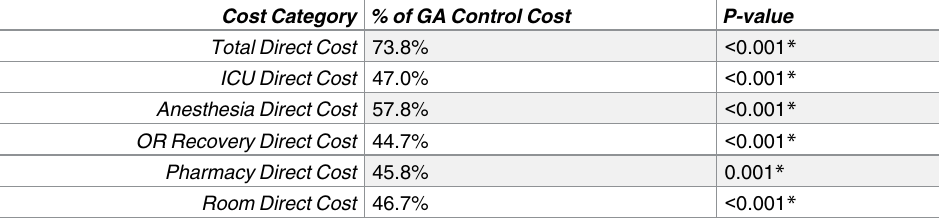
Table 8. Conscious sedation cost outcomes, matched patients excluding Sapien 1